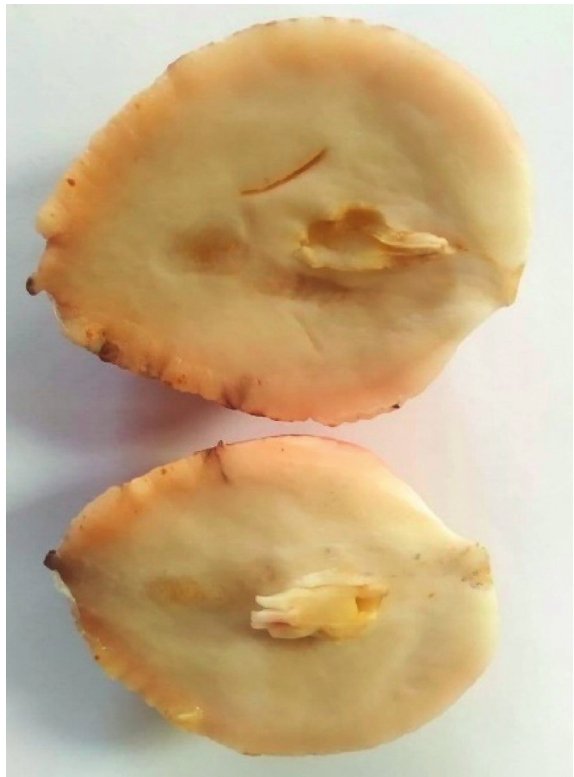
Figure 1: Avocado ( Persea americana )